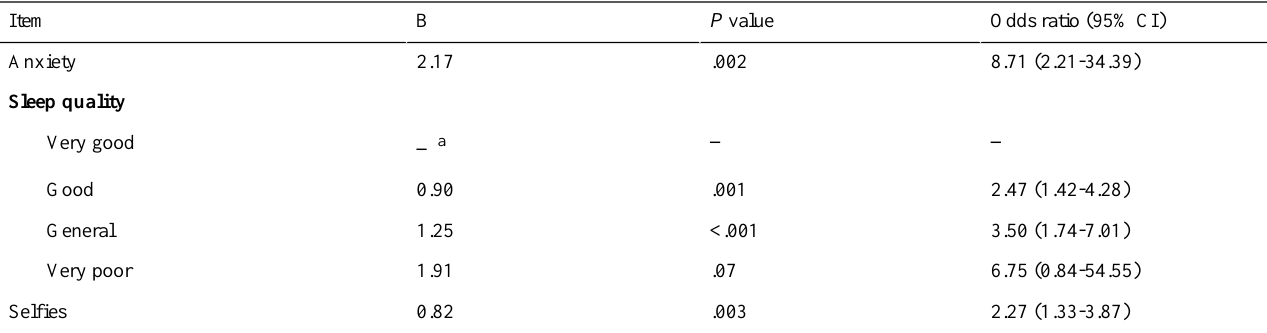
Table 1. Logistic regression analysis of the association between image features and postpartum depression